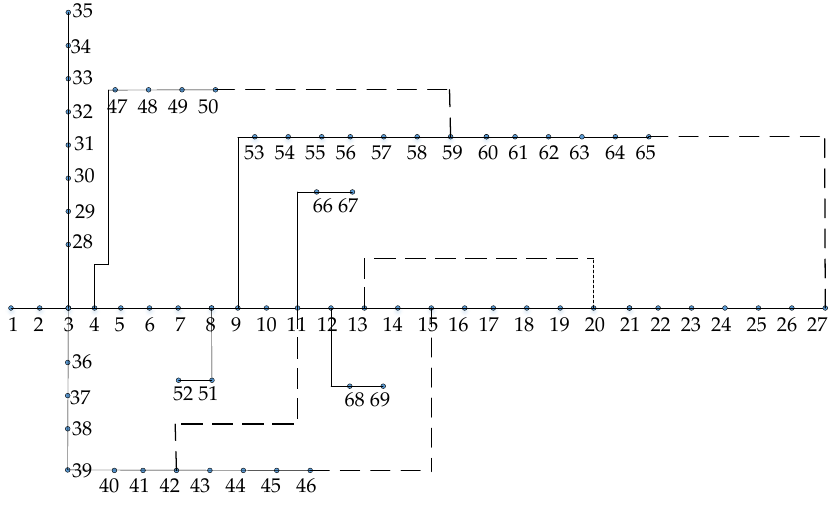
Figure A1. IEEE 34 bus system.